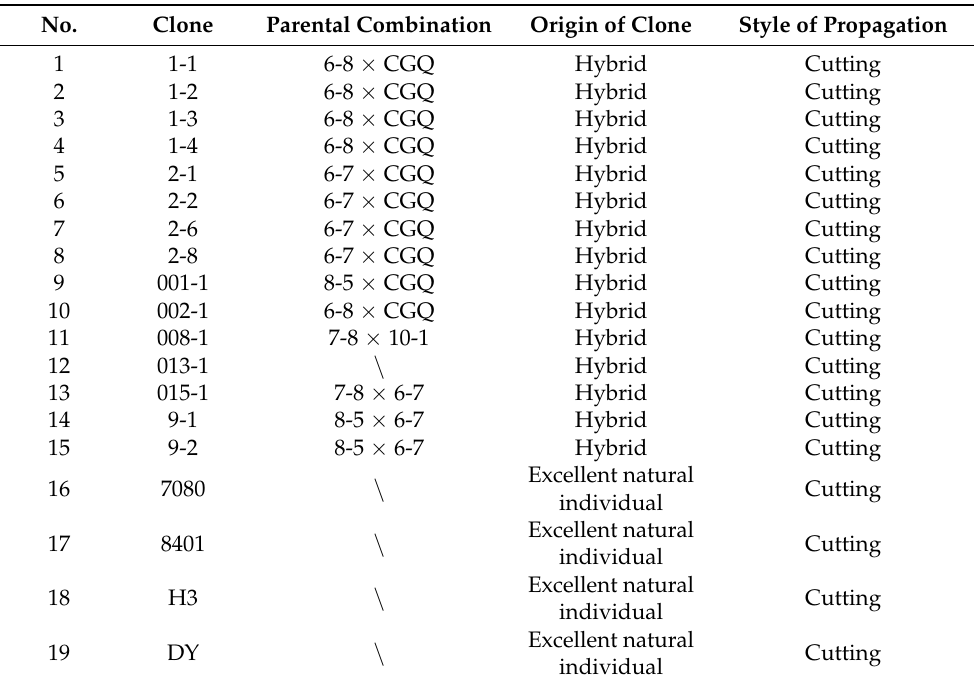
Table 1. The sources of the clones. No. Clone Parental Combination Origin of